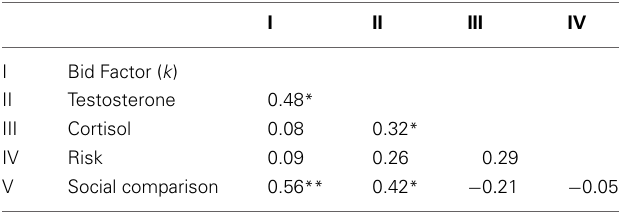
Table 2 | Correlations among variables.